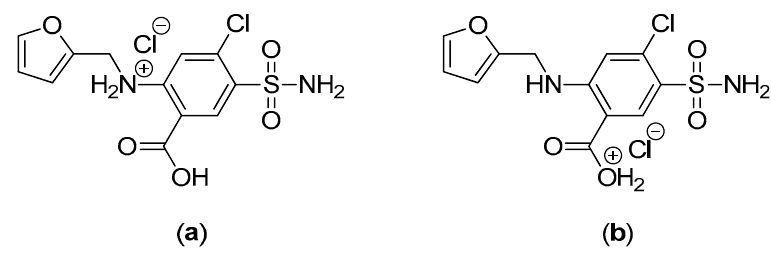
Figure 7. ( a ) Amine-protonated form and ( b ) carboxylic acid-protonated form of